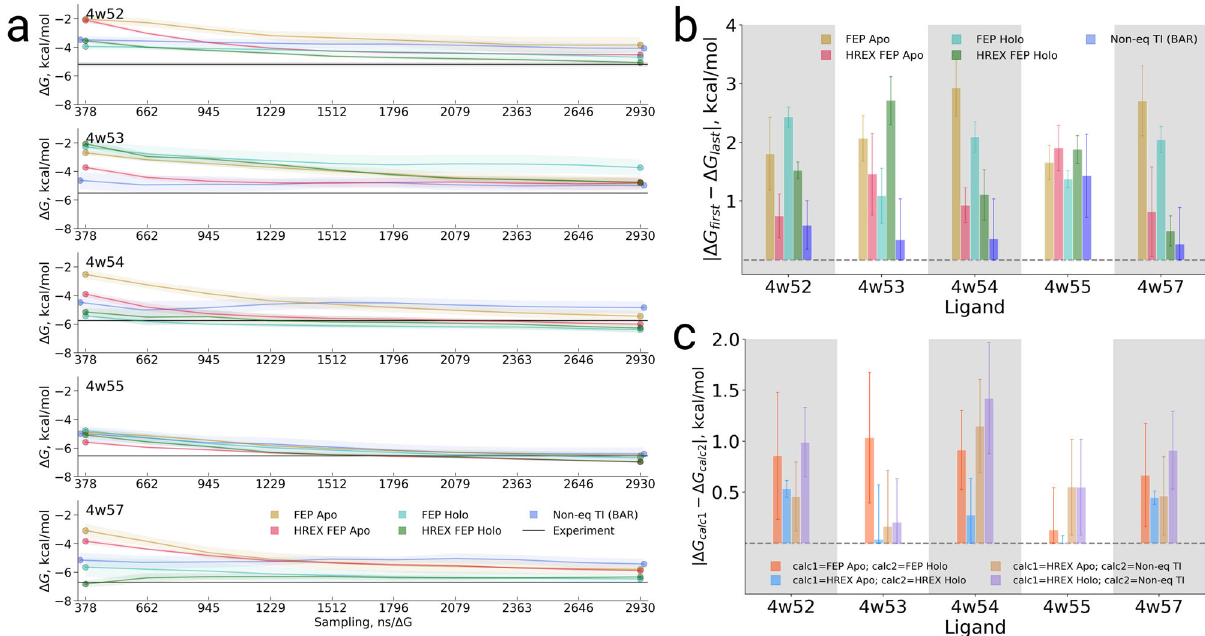
Fig. 7 Free energy calculations of the ligands binding to T4 lysozyme (L99A). a Free energy values calculated with different methods plotted against the sampling time. The time re fl ects only the sampling invested in the protein – ligand coupling part. b Absolute differences between the fi rst free energy evaluation (cumulatively using approximately 380 ns for each method in the protein – ligand coupling part) and the last free energy evaluation (~2900 ns per method). c Absolute difference between the calculated free energy ( fi nal value, ~2900 ns per method) between several selected methods. The uncertainties denote standard errors obtained by